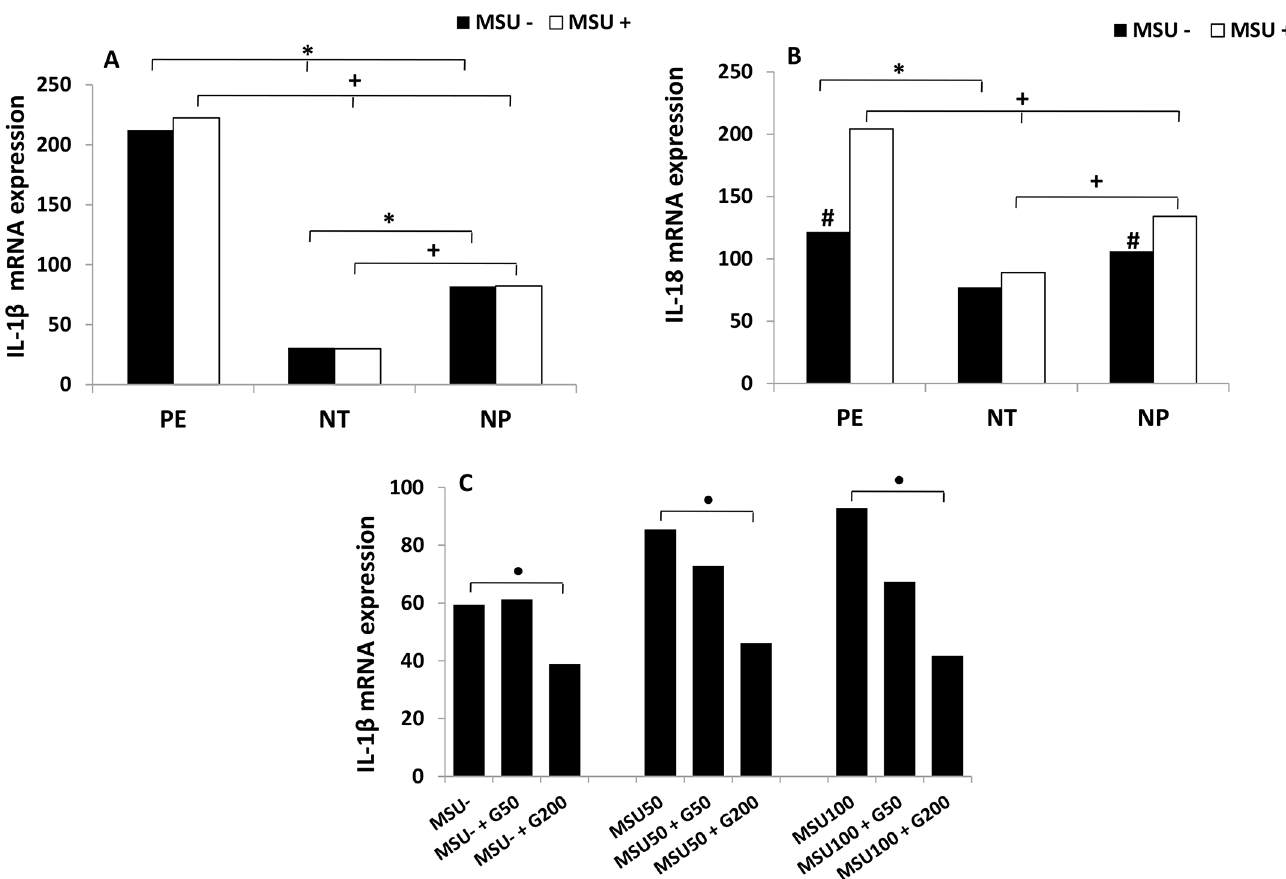
Fig 2. Gene expression of IL-1 β (A) and IL-18 (B) by monocytes. Monocytes from pregnant women with preeclampsia (PE), normotensive pregnant women (NT) and non-pregnant women (NP), were cultured in the presence (MSU + ) or absence (MSU - ) of monosodium urate. Expression of IL-1 β (C) by monocytes from non-pregnant women treated with 50 μ M and 200 μ M of Glybenclamide, in the presence (MSU + ) or absence (MSU - ) of monosodium urate. Results are shown as median. * P < 0 . 05 shows significant difference between MSU - groups; + P < 0 . 05 shows significant difference between MSU + groups; # P < 0 . 05vs MSU + ; ● P < 0 . 05 (MSU - vs MSU - + G200), (MSU50 vs MSU50+G200), (MSU100 vs